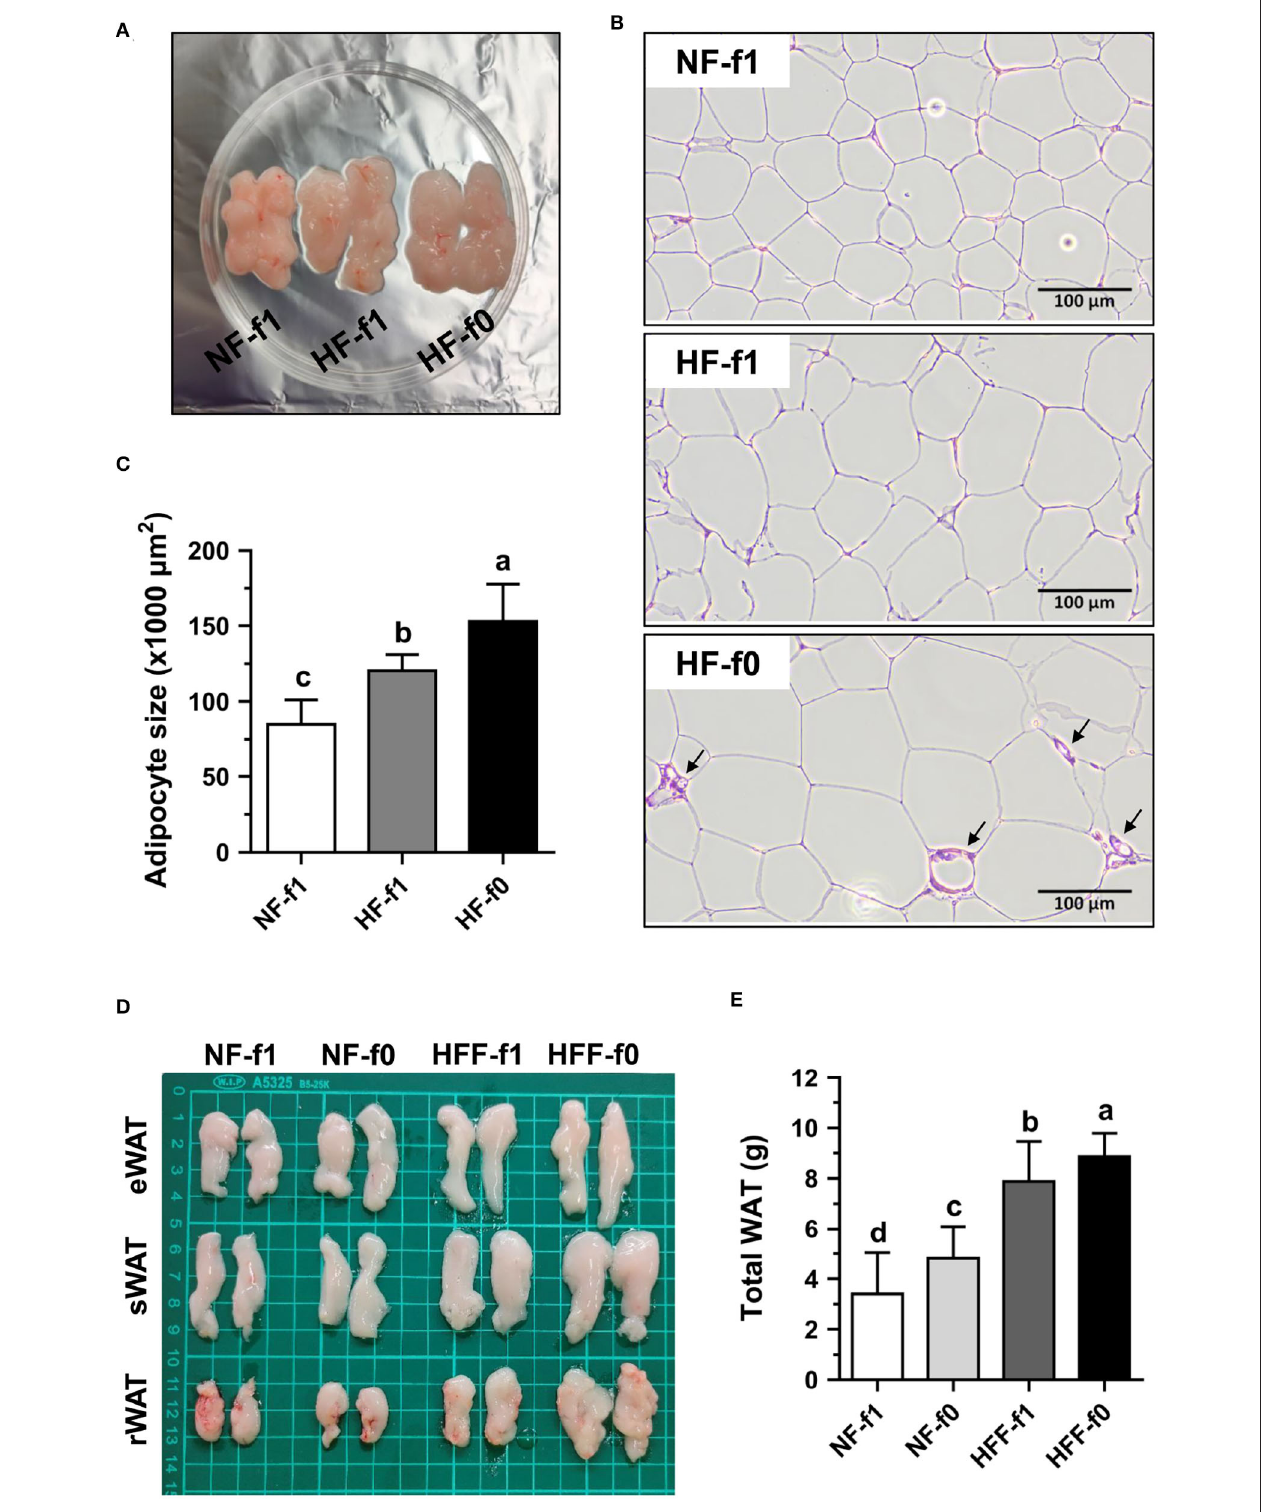
FIGURE 4 | Folate deficiency increased adipocyte size of mice fed with high-fat (HF) and fat pad of mice fed either NF or high-fat high-fructose (HFF) diet for 12 months. The representative images of (A) epididymal WAT (eWAT) fat pad, (B) hematoxylin and eosin (H&E)-stained eWAT, the arrow indicates fibrotic lesion, and (C) the quantification of adipocyte size in eWAT from NF or HF diet-fed mice. The representative images of (D) eWAT, subcutaneous WAT (sWAT) and perirenal WAT (rWAT) fat pads, and (E) total weight of WAT from NF or HFF diet-fed mice. Data are mean ± SD ( n = 10–16 per group). Bars with different letters indicate significant differences ( p < 0.05) analyzed using one-way ANOVA and Duncan’s post-hoc test.